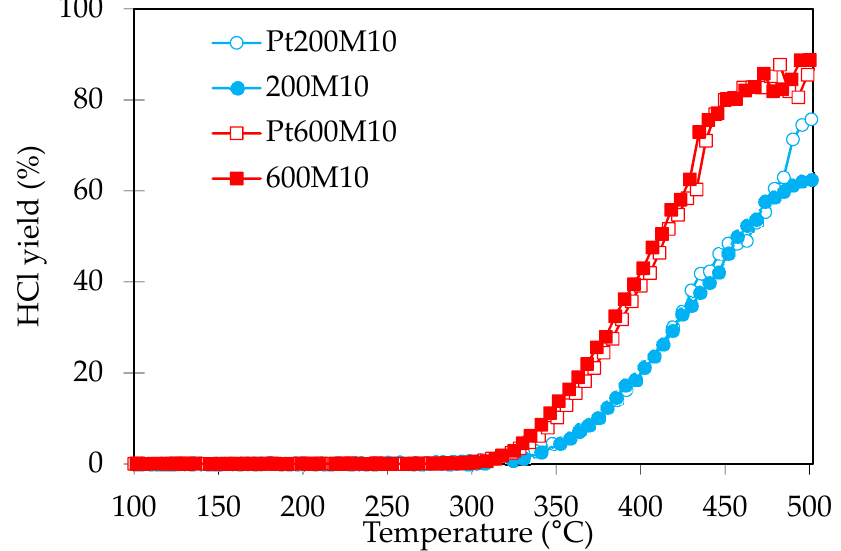
Figure 10. Comparison of HCl yield between coated monoliths (200M and 600M10) with AlSi10 in presence of Pt (open symbols) or not (closed symbols). The same experimental conditions were used as in Figure 6.